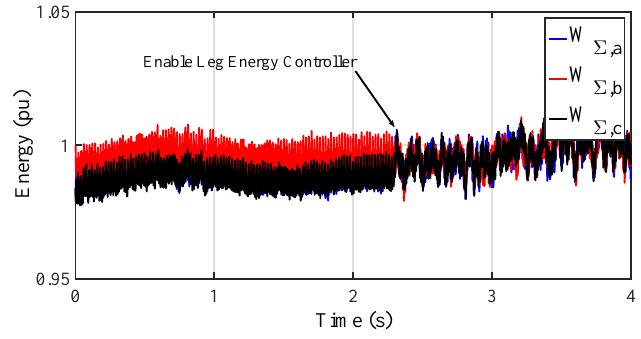
Figure 8. Leg energy controller experimental